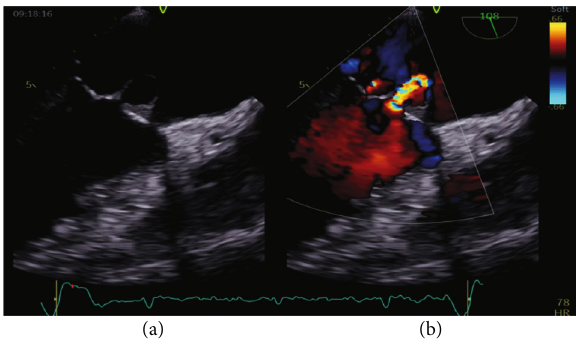
Figure 2: (a)MVaneurysm.(b)Aneurysm-relatedMVregurgitation.